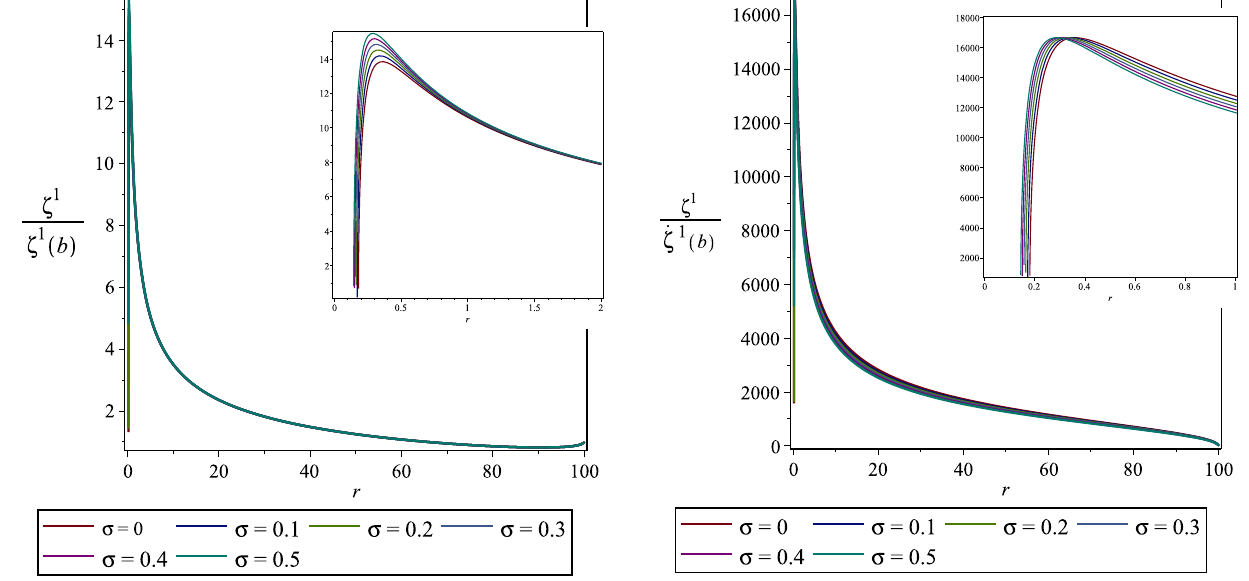
Fig. 6 Radial components of geodesic deviation for a Kiselev BH sur- rounded by dust with IC1 for different values of the dust parameter with M = 1, q = 0 . 6 and b = 100